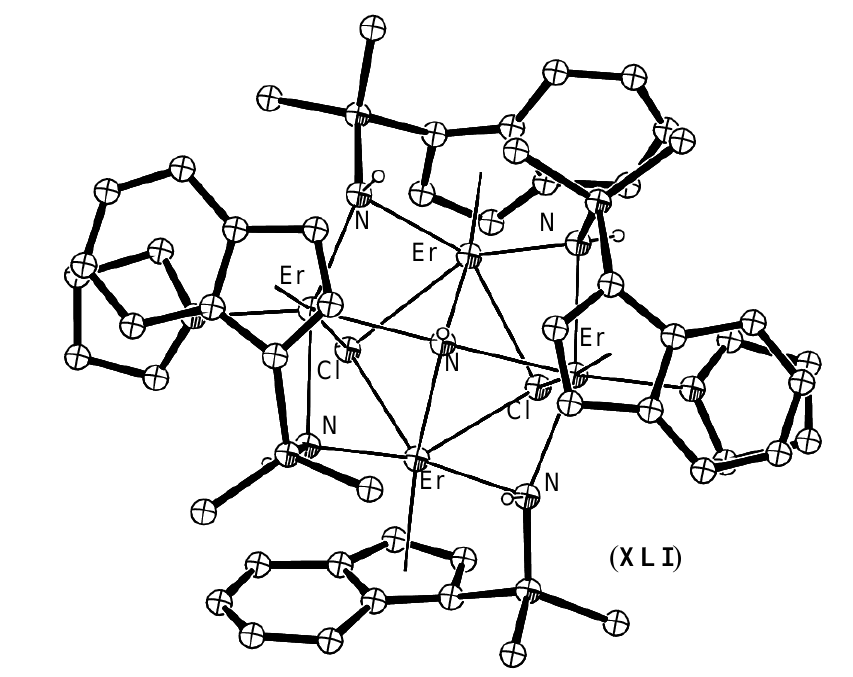
Figure 16. Erbium imide cluster XLI [61]. Figure generated from CCDC obtained coordinates. Atoms of arbitrary size. Non-nitrogen H atoms are omitted for clarity.